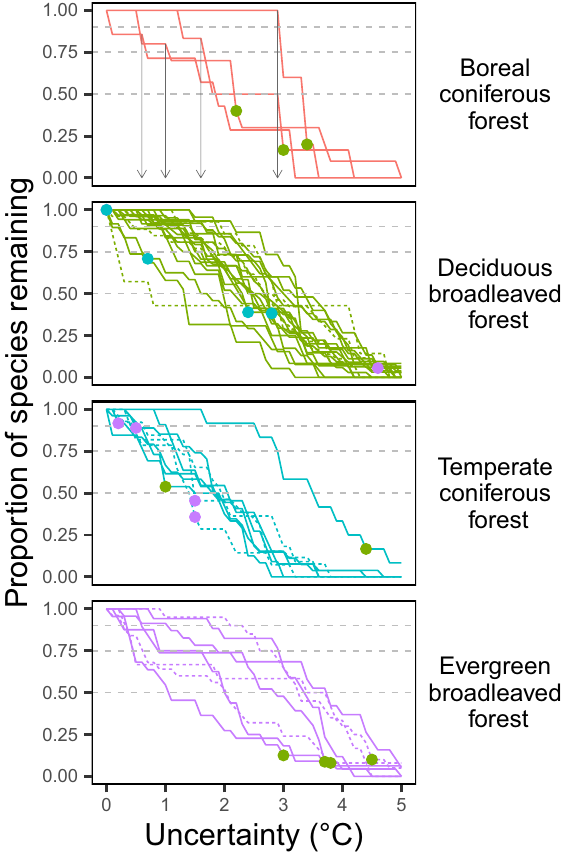
Figure 5. Species richness of the 42 forest plots at their worst-case scenarios with increasing uncertainty in TM MAT ( k ). Dashed horizontal lines indicate 90%, 75%, and 50% of the initial species richness maintained at TM MAT . Points on the lines indicate change from the initial forest type, and the color indicates the shifted forest type (see Fig. 3). In the top panel showing the four boreal coniferous forest plots, arrows indicate maximum acceptable uncertainty (0.1 °C interval) for 75% species maintenance in each plot.